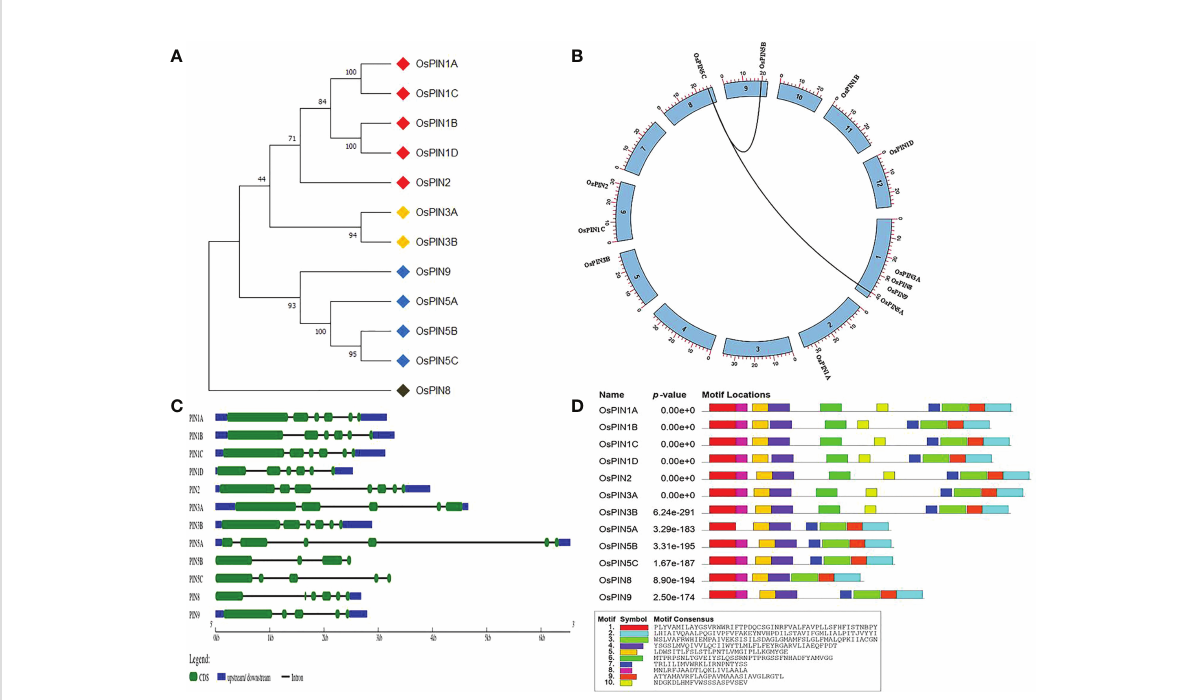
FIGURE 1 Phylogeny, chromosomal location, gene structure, and protein domains in 12 PINs of rice. (A) The phylogenetic tree of PIN proteins showing relative evolutionary relationships among themselves. (B) Genome organization of rice PIN genes on eight chromosomes of rice. (C) Exon- intron distribution of rice PIN genes. (D) Conserved protein domains identi fi ed in rice PIN proteins. Out of 10 motifs, seven were common in all of the PIN